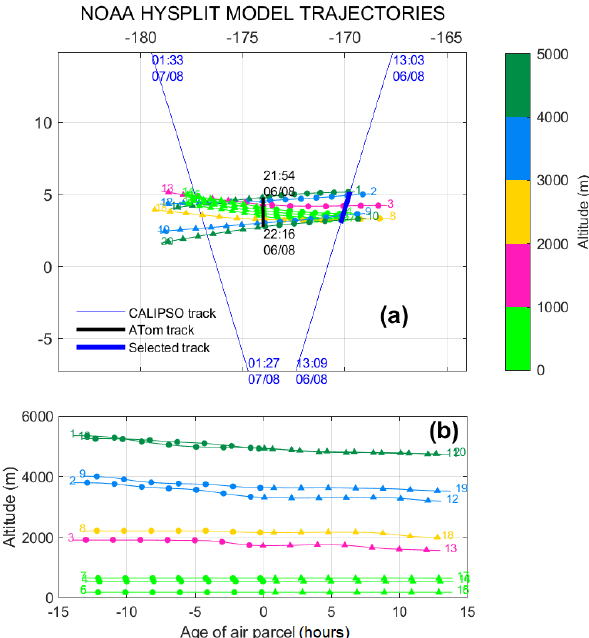
Figure 3. (a) CALIPSO overpasses (dark blue lines) close to the ATom measurements on 6 August 2016 with HYSPLIT backward (lines with filled circles) and forward (lines with filled triangles) trajectories starting and ending at different points along the ATom track. The colour bar represents the altitude of the ATom coordi- nates used to compute the HYSPLIT trajectories. The CALIPSO track selected for comparison is highlighted as a bold blue line in the CALIPSO overpass at 13:04UTC on 6 August 2016. (b) Verti- cal displacement of the air parcels along the individual HYSPLIT trajectories. Each track is associated with a number to identify its vertical displacement and time